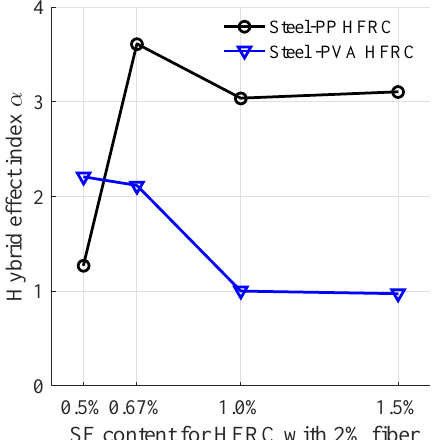
Figure 13. Hybrid effect index in terms of impact